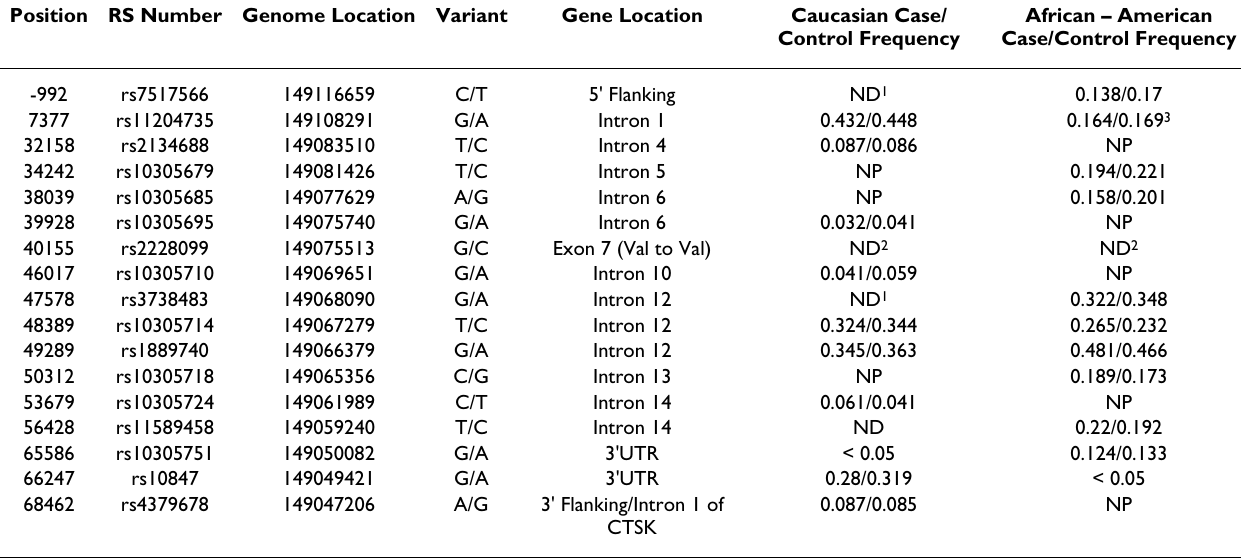
Table 2: Summary of single nucleotide polymorphisms and allele frequencies Position RS Number Genome Location